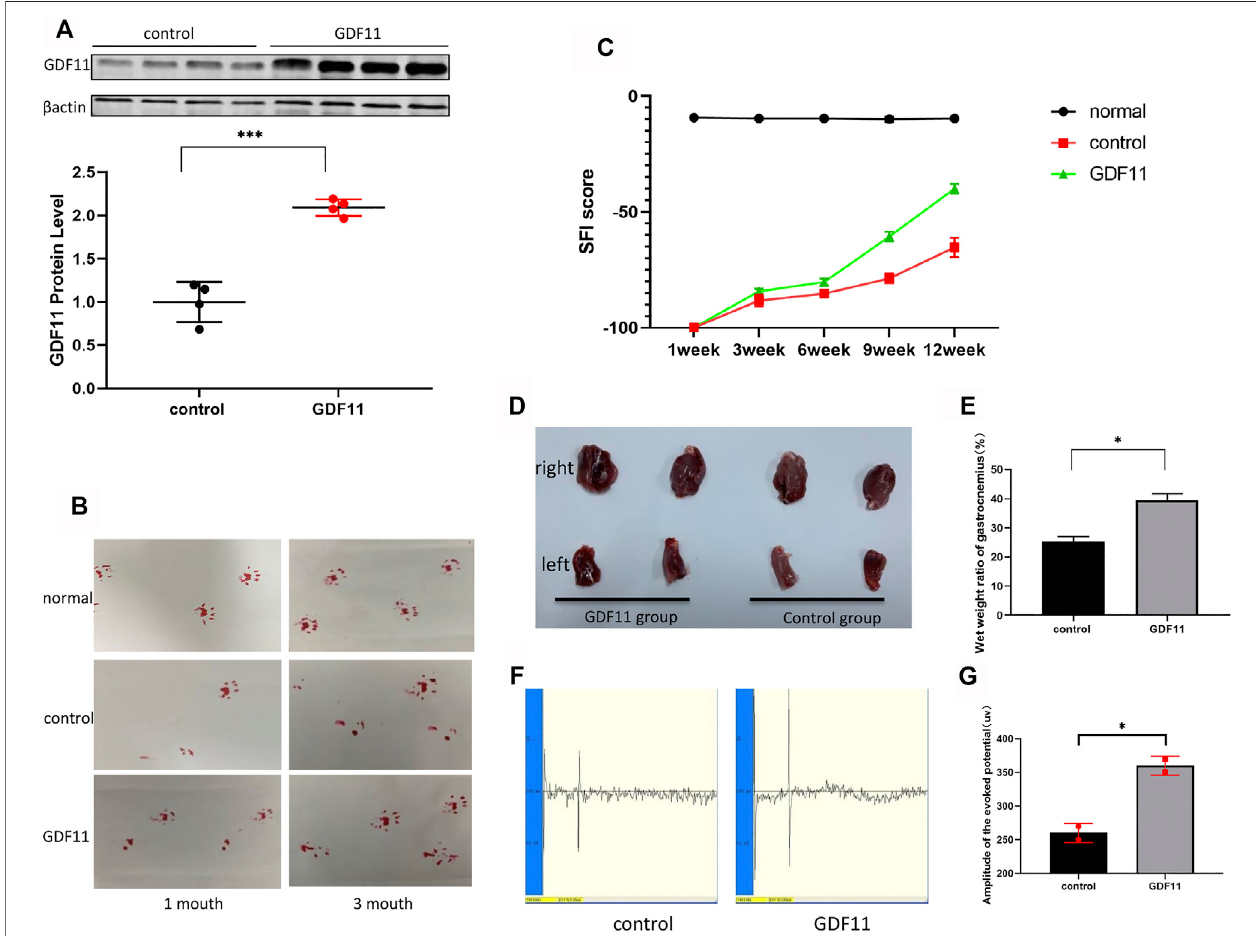
FIGURE4| GDF11promotestherecoveryofdamagedsciaticnervefunctioninrats. (A). Onemonthaftersurgery,thesciaticnervesoffourratsineachgroupwere randomly selected, and the expression of GDF11 was detected by Western blot. (B). The recovery of sciatic nerve function was observed by foot print test at 1 and 3 months after operation. (C). SFI value was used to evaluate the recovery of sciatic nerve function in rats at different time points ( n (cid:1) 3). (D and E). Gastrocnemius atrophy of rats 3 months after operation ( n (cid:1) 3). (F and G). The nerve conduction function of rat sciatic nerve was measured by action evoked potential (MEP) at 3 monthsafteroperation( n (cid:1) 3).Statisticalanalysiswasbasedonatleastthreedifferentbiologicalsamplesandthreetechnicalreplicates, p < 0.05wasconsideredtobe statistically signiand fi lig;cant. Representative images are